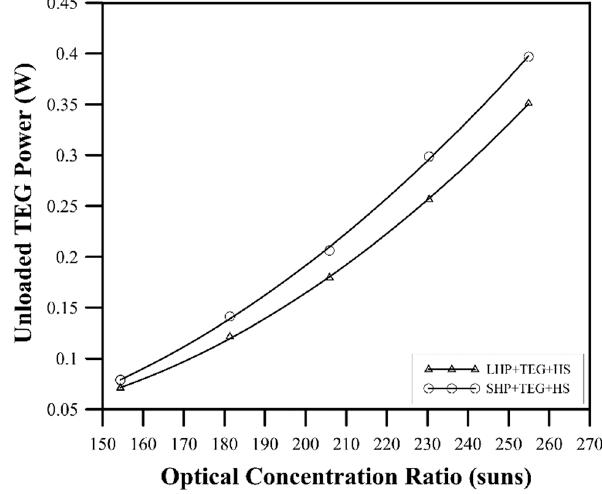
Figure 10. Unloader generated power of the TEG attached to the long and the short HP, respectively, as a function of the optical concentration ratio.